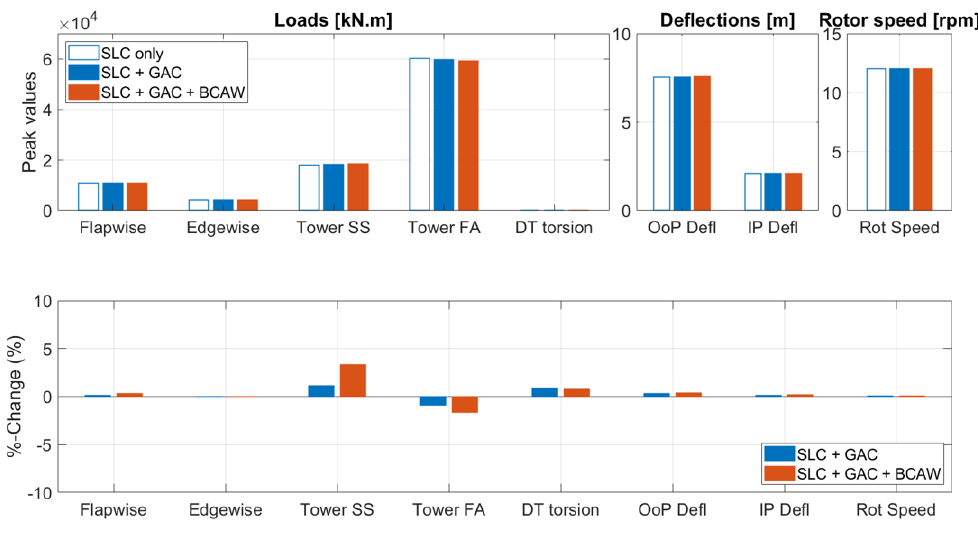
Figure A9. Variation of the maximum absolute transient (peak) values of the primary and secondary metrics under DLC 1.5 with different control architectures. Top—Peak dimensional values; Bottom— Percentage changes with respect to ‘SLC Only’